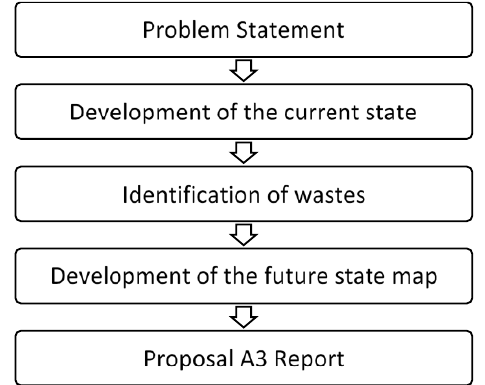
Figure 1. Methodology applied in the present case study.